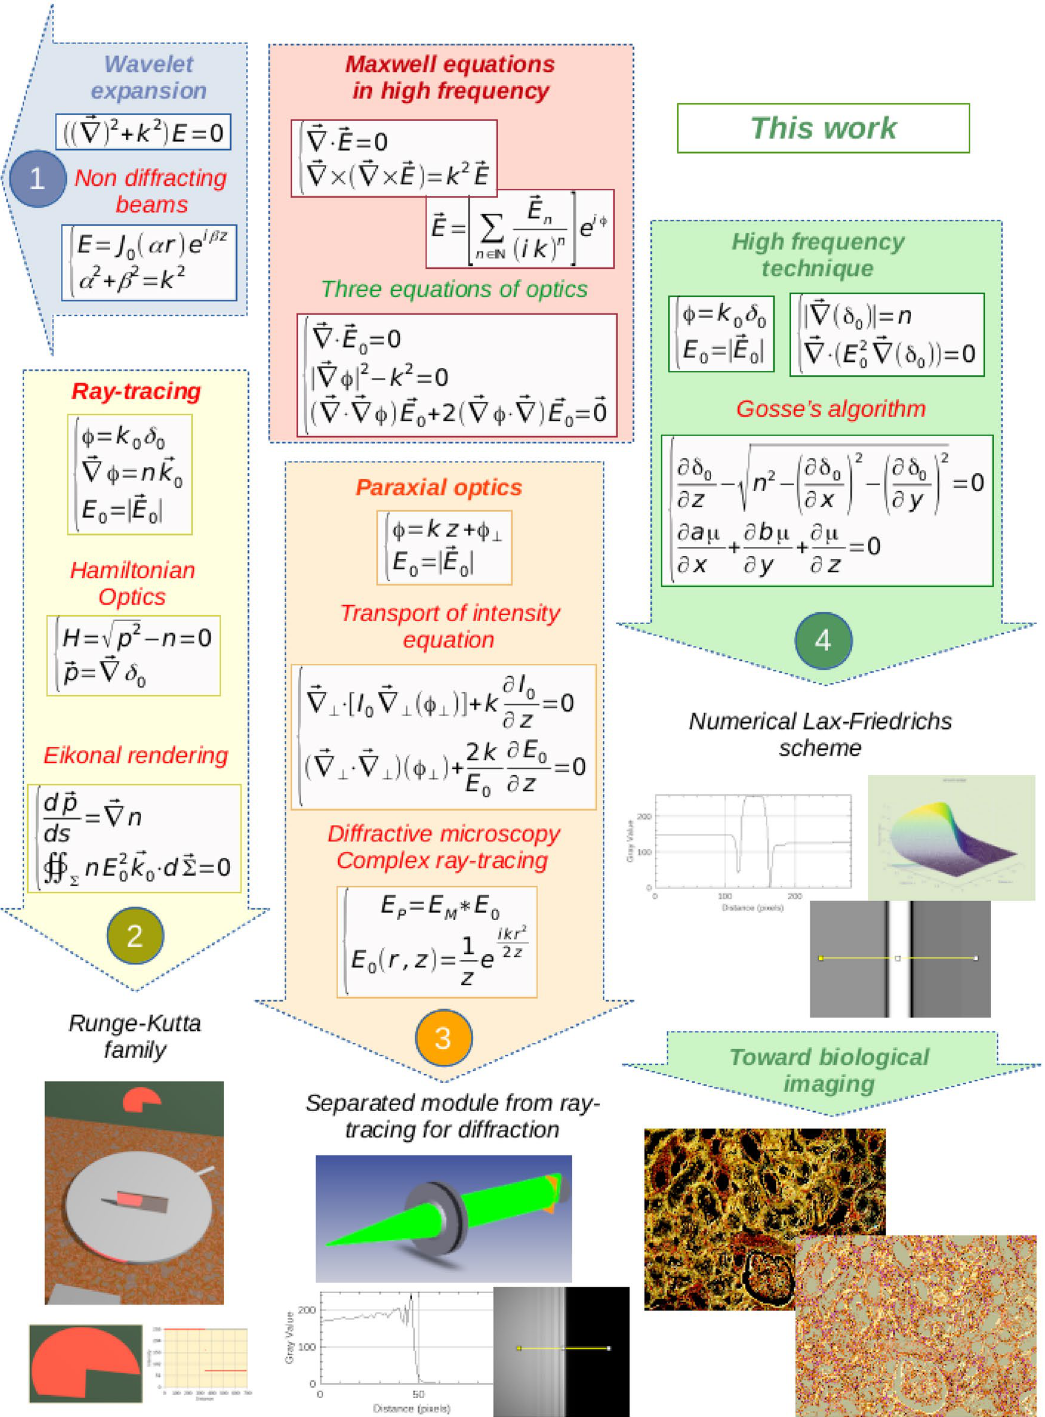
Figure 1. Three computational methods (2, 3, 4) deployed to study photonics-based